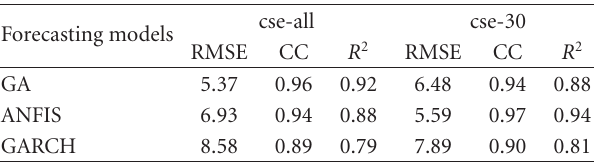
Table 9: Performances for testing